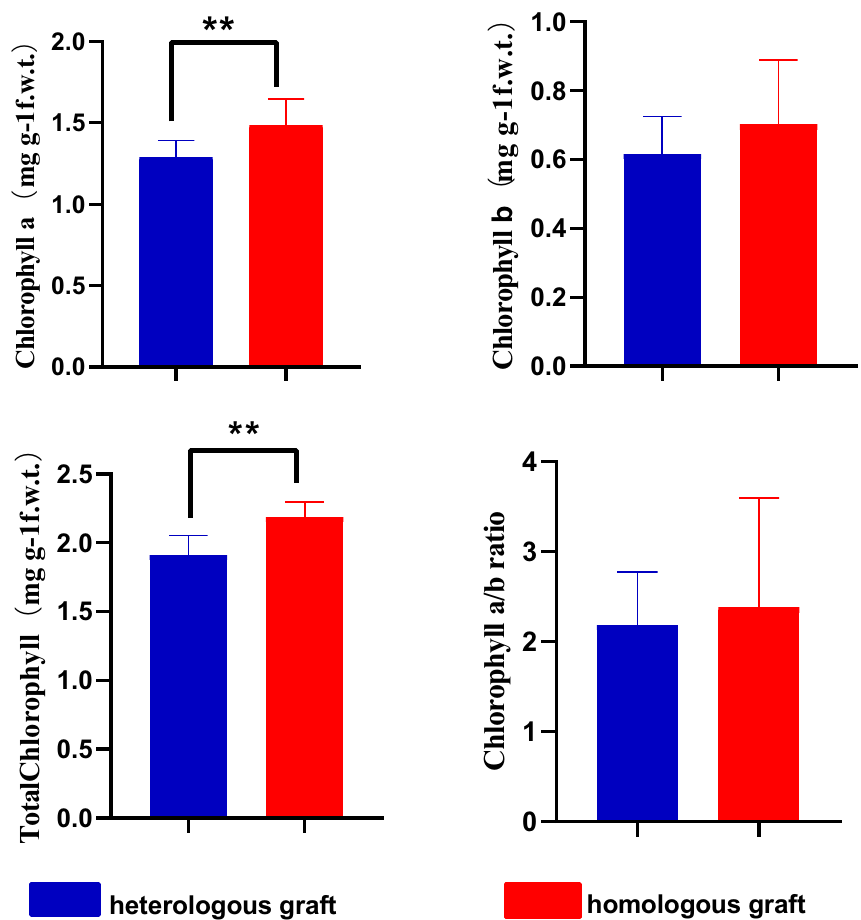
Figure 1. Chlorophyll a(Chl a),Chlorophyll b(Chl b),Total chlorophyll (T Chl) and chlorophyll a/b ratio (Chla/b) of scion leaves in two grafted groups. A significant difference between grafted groups was indicated by ** ( P < 0.01) using the Student’ s t-test.